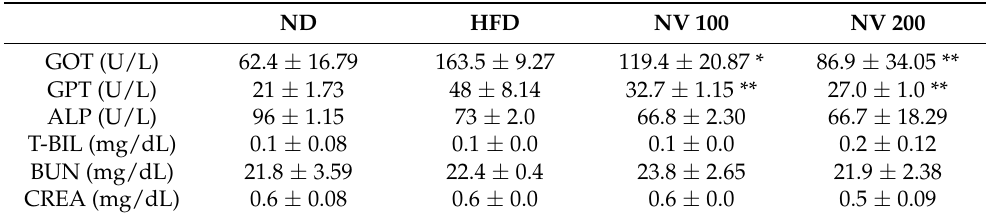
Table 2. Plasma biochemical values. Significant differences from the HFD group are indicated by ** p < 0.01 and * p < 0.05.